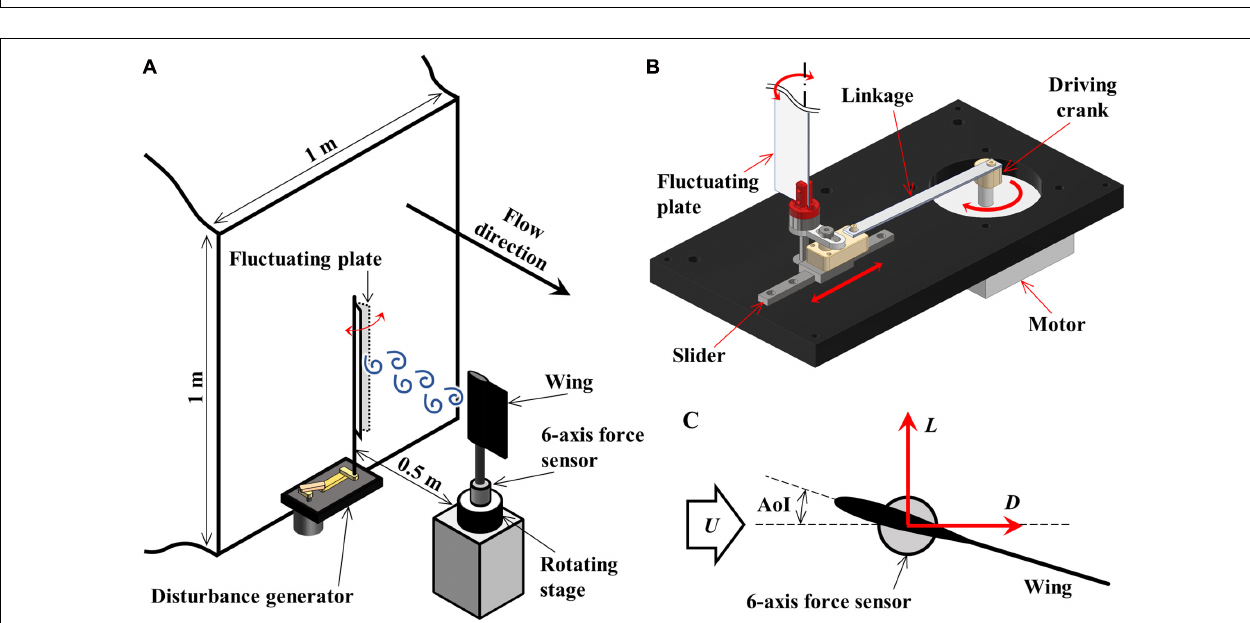
FIGURE 1 | Schematic diagram of panel (A) a bird wing and a cross-section and (B) the bird-inspired wing model.